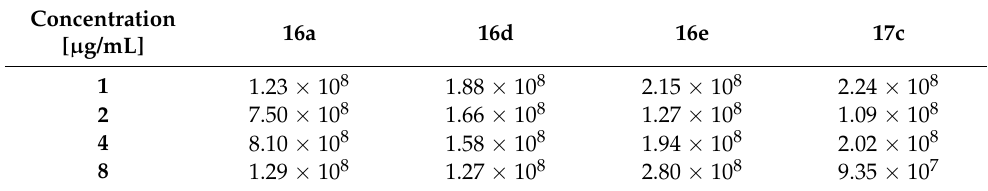
Table 2. The results of the measurement of the number of viable cells of Staphylococcus aureus after the action of the tested compounds at various concentrations.